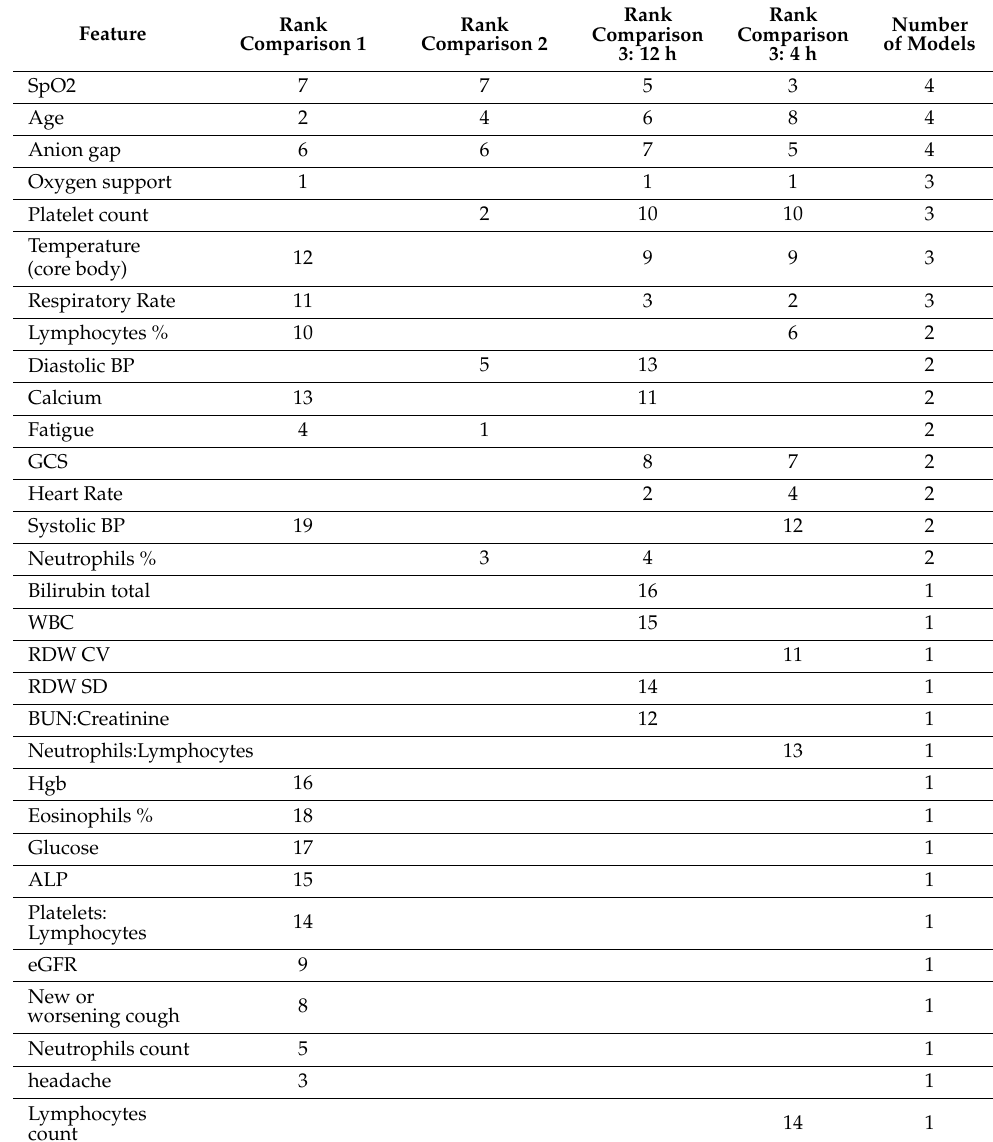
Table A7. Ranks and numbers of times covariates appear in the various multivariate